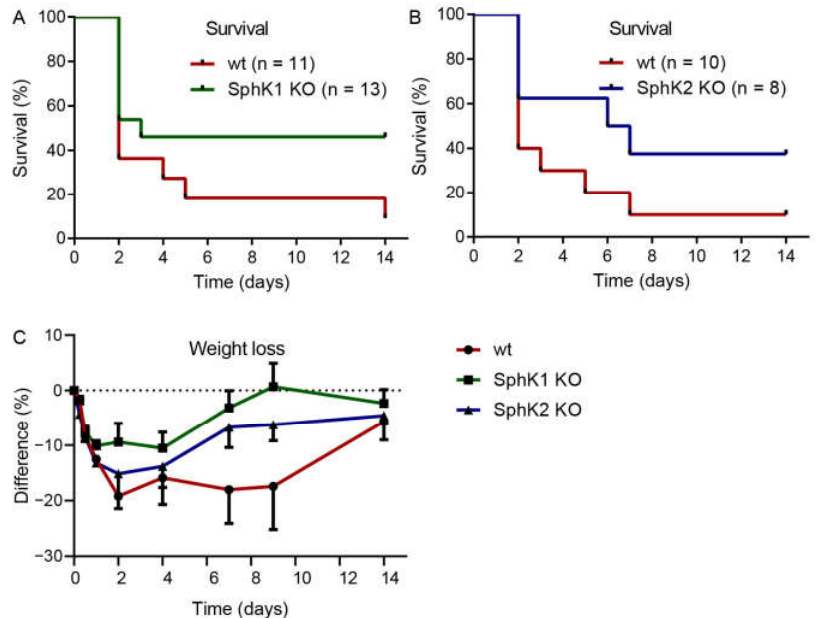
Figure 2. Kaplan–Meier curves demonstrating the survival rate of infected ( A ) wt versus SphK1 − / − mice and ( B ) wt versus SphK2 − / − mice over the time course of 14 d. Numbers of animals in each group are given in parenthesis. ( C ) Weight loss of wt, SphK1 − / − and SphK2 − / − mice post infection, n = 3–21, depending on the number of surviving mice at each time point.